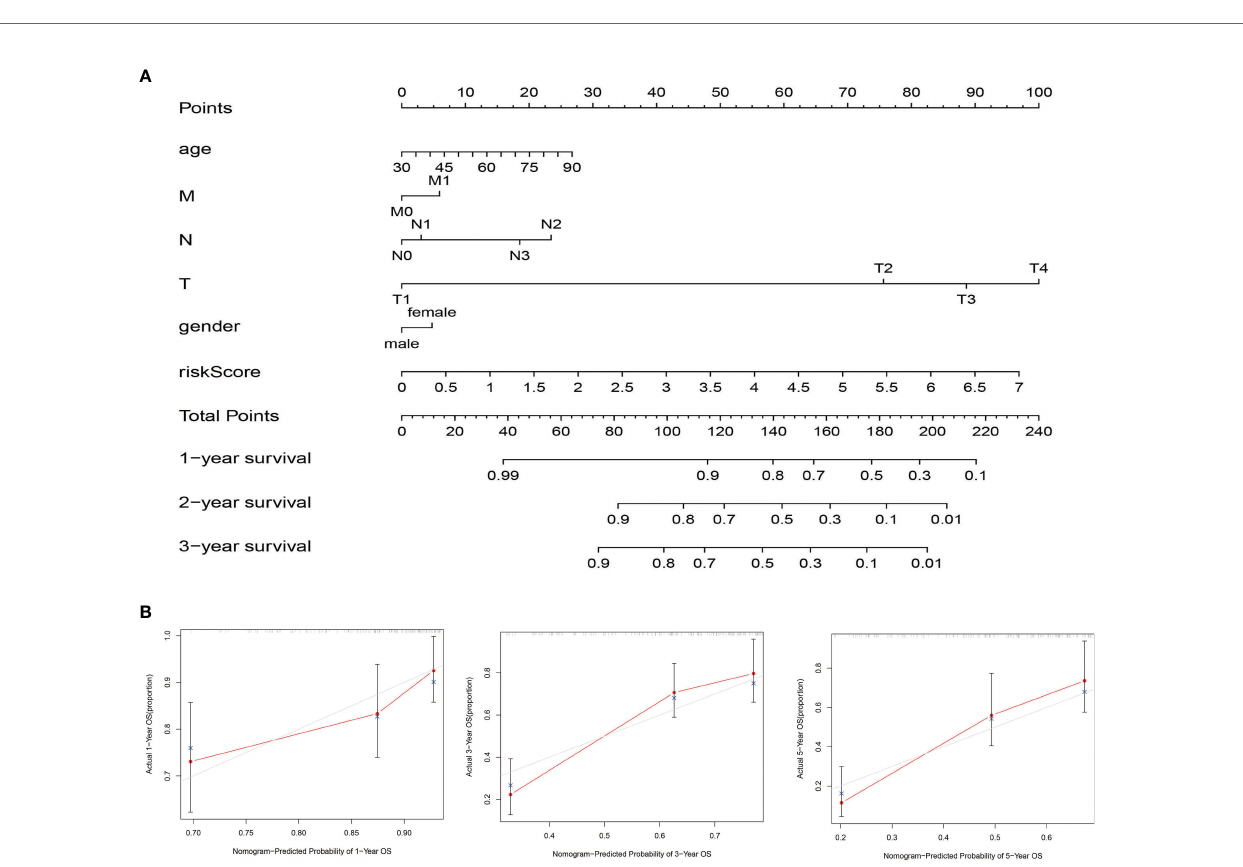
FIGURE 7 | Construction and validation of the nomogram in the TCGA cohort. (A) The nomogram for predicting the OS of patients with BLCA at 1, 2, and 3 years in the TCGA dataset. (B) Calibration curves of the nomogram for OS prediction at 1, 3, and 5 years in the TCGA dataset.